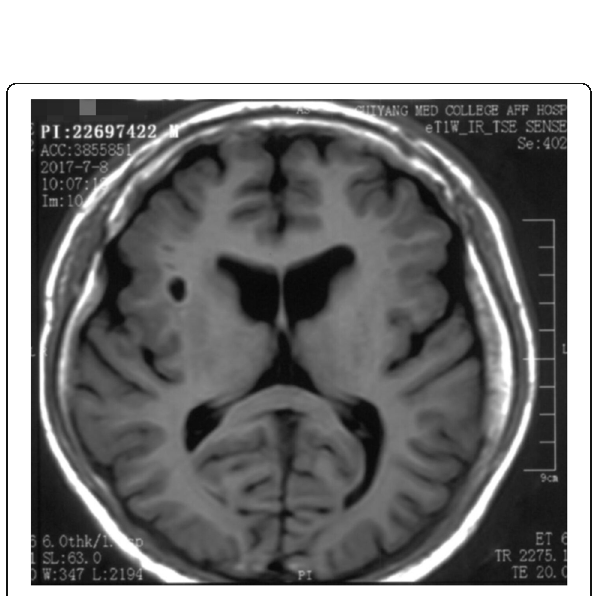
Fig. 8 MRI T1-weighted image shows a cystiform lesion under the right insular